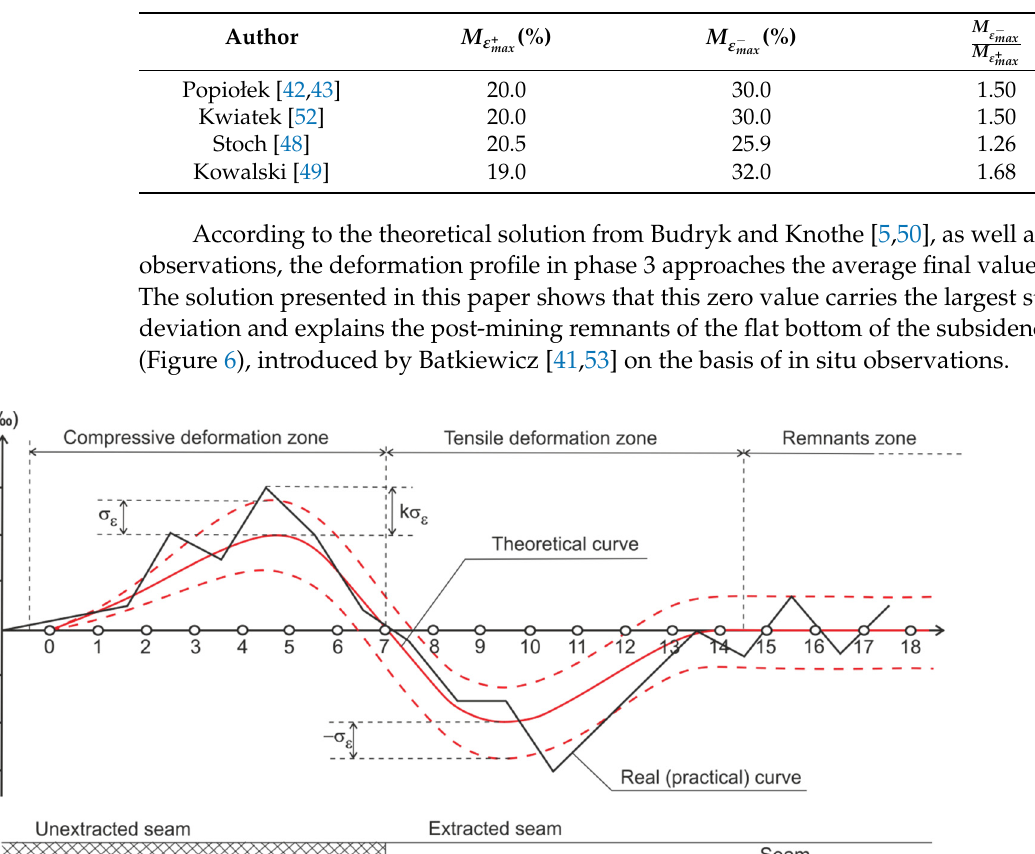
Table 1. Summary of results from past research that is related to the variation coefficient values for the maximum values of tensile and compressive strain (own study).